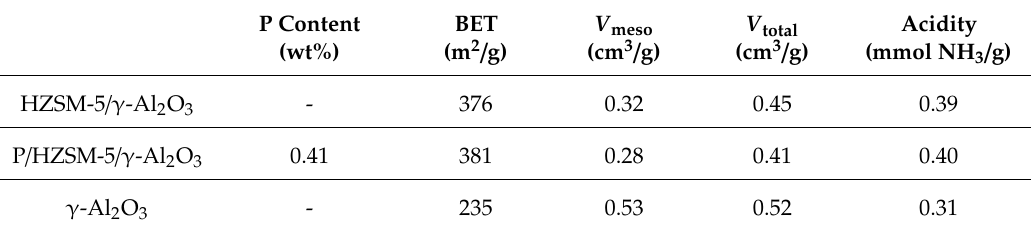
Table 1. Textural properties (determined by N 2 physisorption) and acidity of the di ff erent catalysts